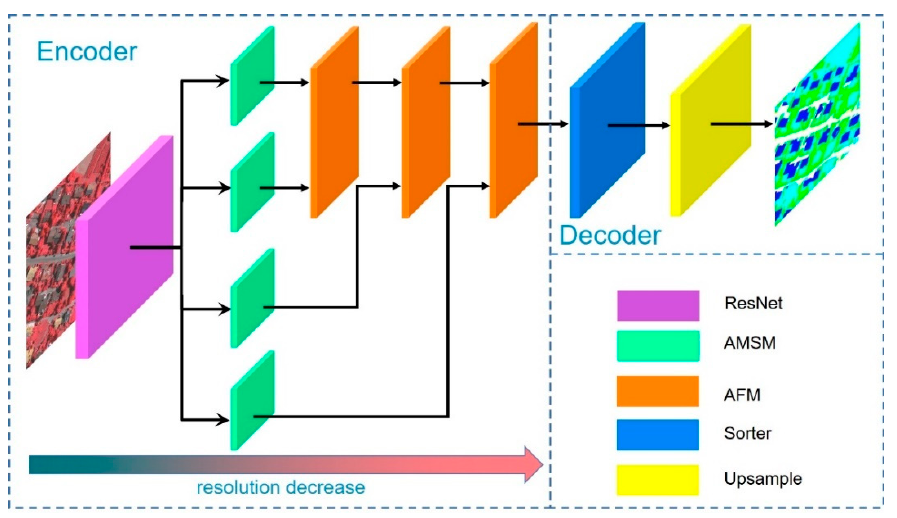
Figure 2. The overall structure of the network. The encoder/decoder framework used in this network is mainly used to test the segmentation effect of the adaptive multi-scale module and the adaptive fuse module.